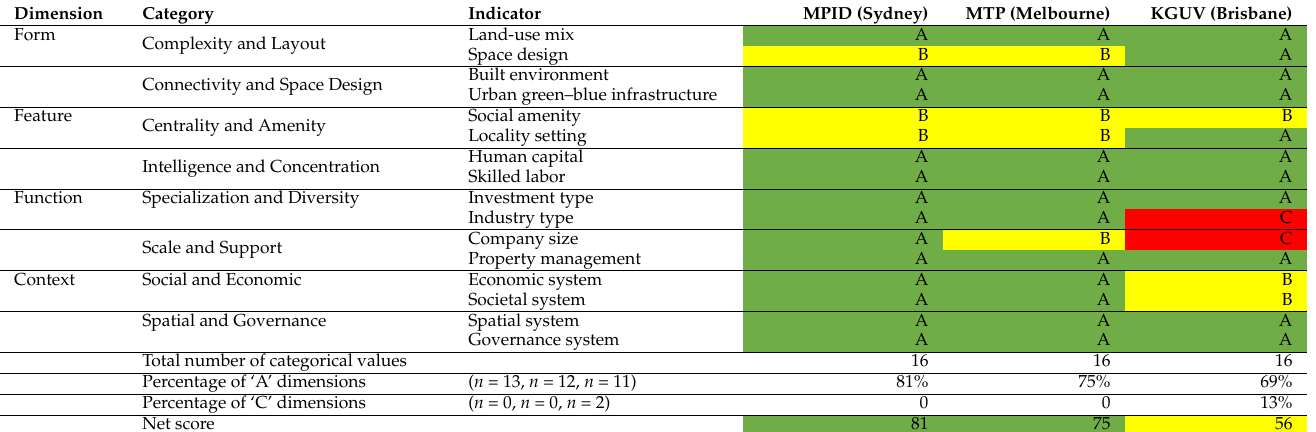
Table 4. Case study categorical performance